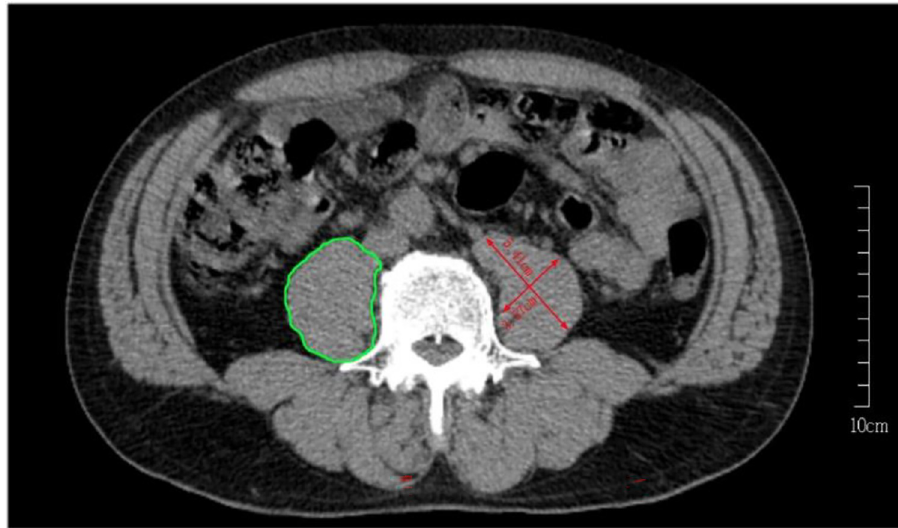
Fig 2. Computed tomography image of spine L3-L4. The red line is the length calculated by the software, and the area surrounded by the green line is the left psoas muscle using the software Slice-O-Matic.